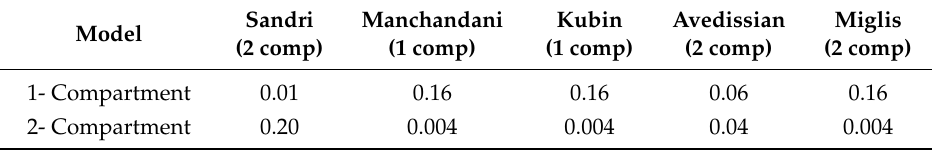
Table A2. Summary of AUC correlation (r 2 ) using di ff erent compartment models. Sandri Model (2 comp) (1 comp)